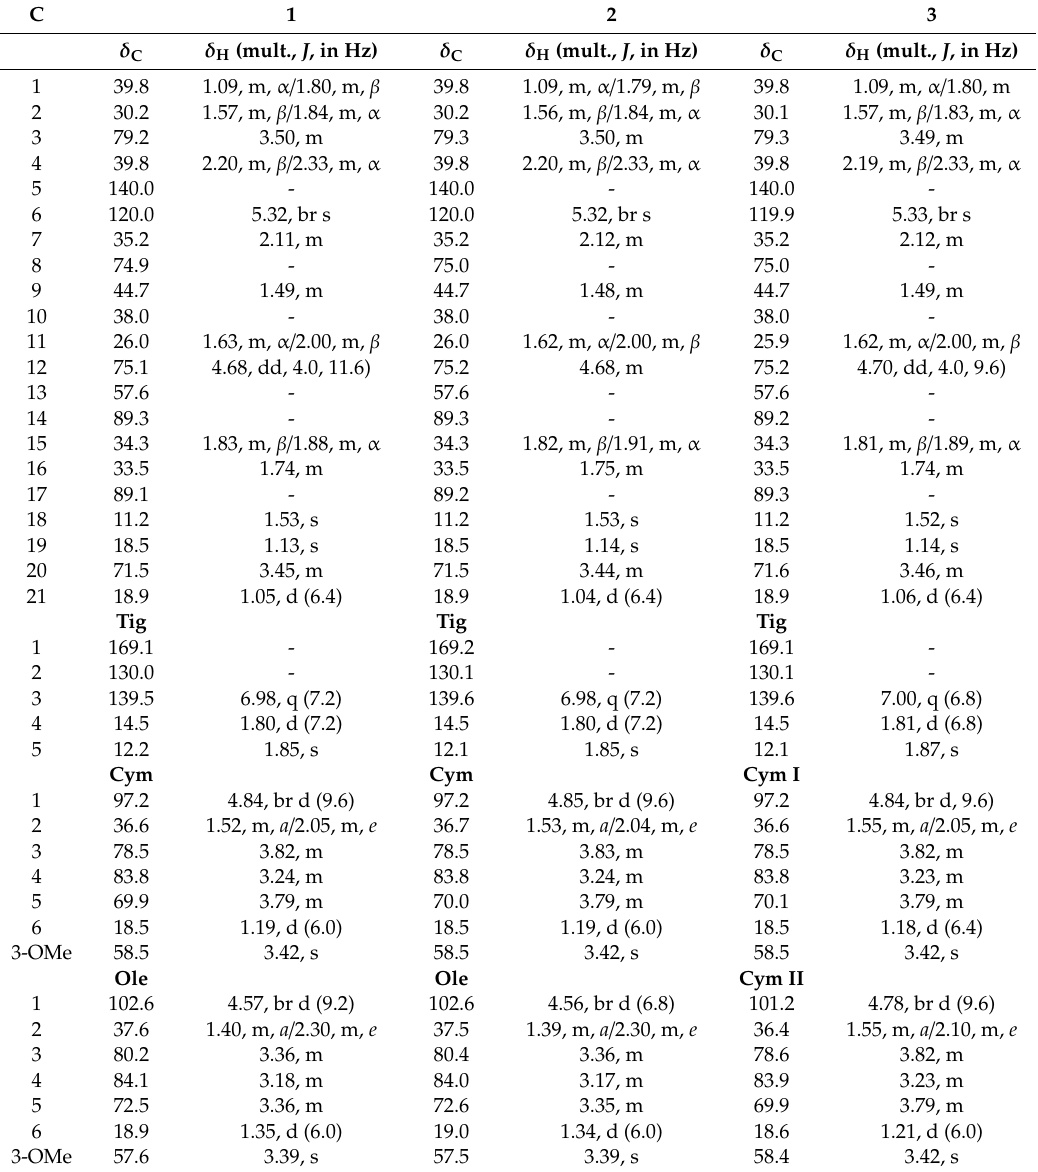
Table 1. NMR spectroscopic data for compounds 1 – 3 in CD 3